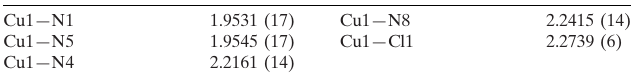
Selected bond lengths (A˚ ).